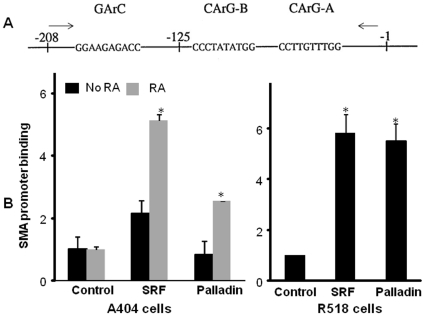
Chromatin immunoprecipitation assay showing that palladin associates with the SMA promoter in differentiated A404 cells and rat aortic SMCs.A) Schematic structure showing the SMA promoter region amplified in ChIP assay. B) Undifferentiated A404 cells were differentiated into SMCs with RA. A404 cells were harvested 48 h after RA treatment, and chromatin IP was performed. Subconfluent R518 cells under normal culture condition were harvested and ChIP assays performed with SRF and palladin antibodies. The intensity of SMA promoter was quantified with real time PCR. No antibody was used as negative control. Values represent the mean±SEM (n = 3). *, p<0.05.